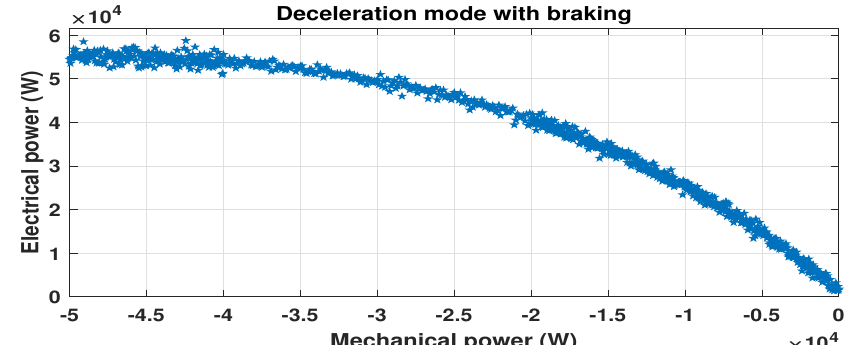
Figure 9. Efficiency of electric vehicle in deceleration mode with using braking system.